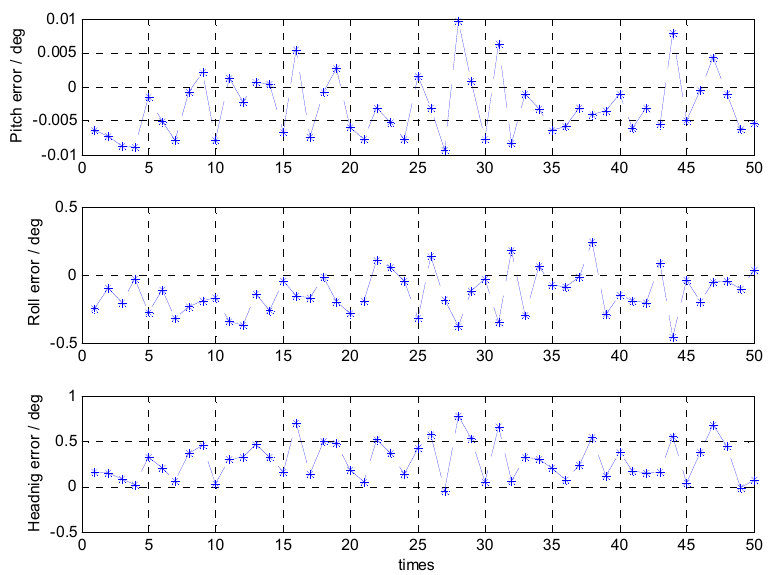
Figure 8. Attitude errors of the coarse alignment using the trial data.